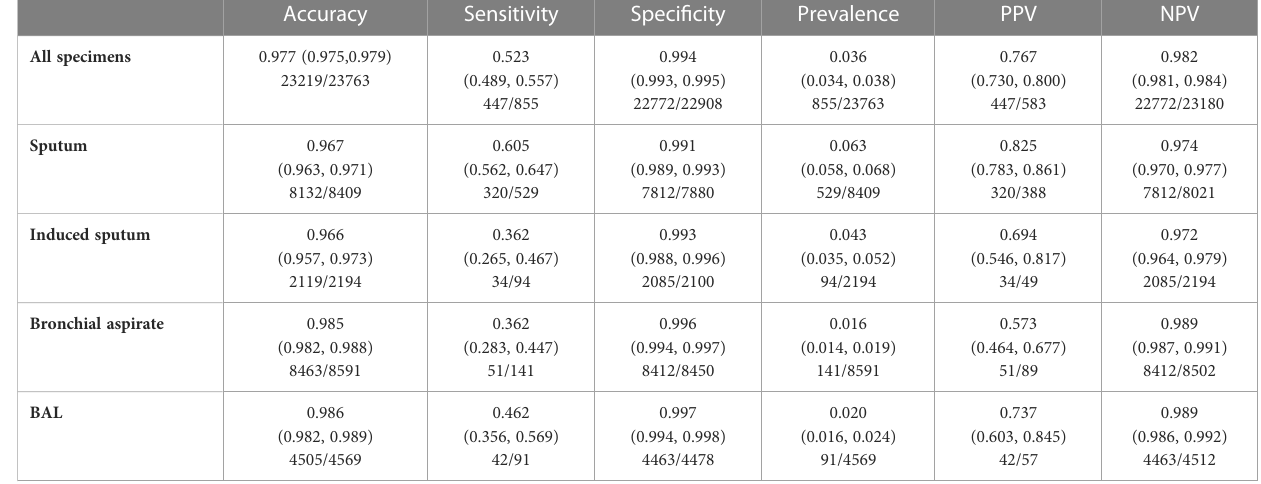
TABLE 1 Performance of smear microscopy for the diagnostic of pulmonary tuberculosis according of the type of specimen.